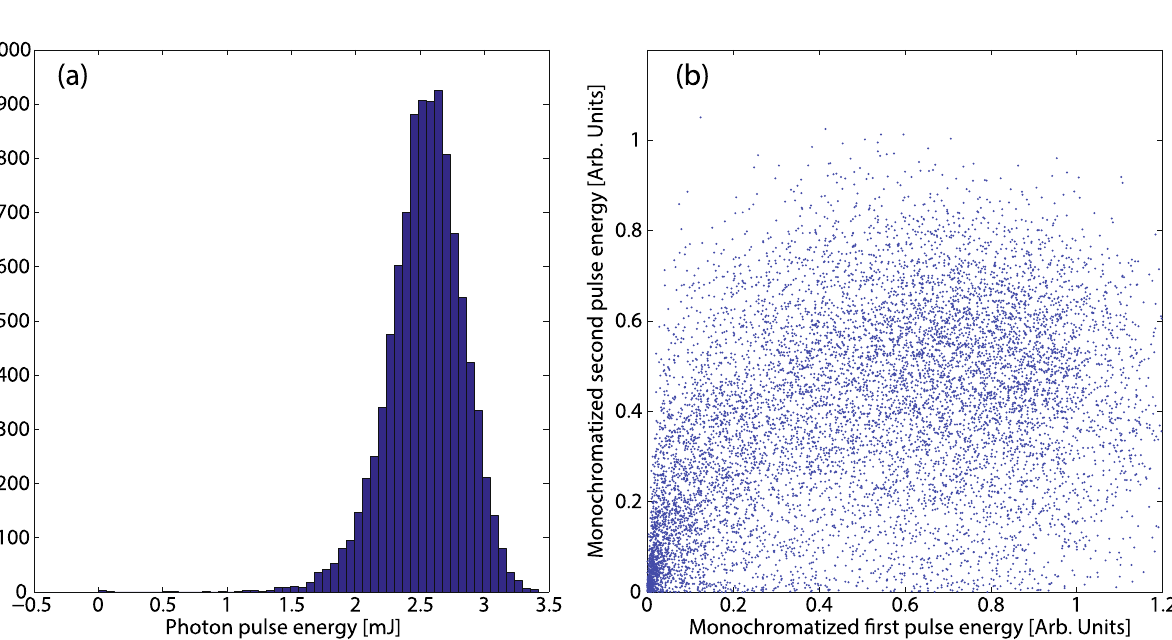
Figure 6. ( a ) Pulse energy histogram for two-bucket double pulses before monochromator. ( b ) Intensity of the first pulse vs intensity of the second pulse on 10000 consecutive shots after the